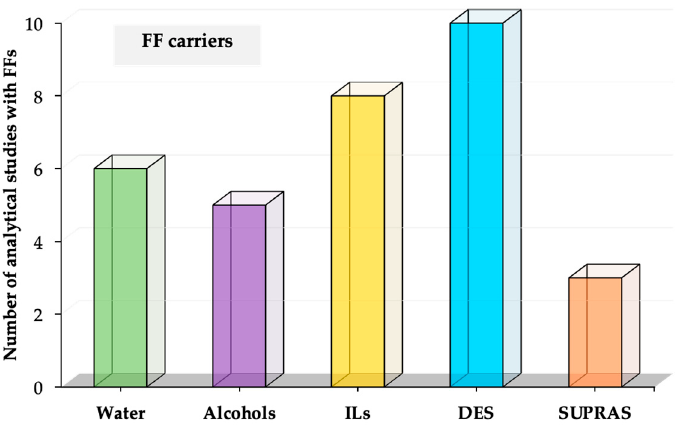
Figure 2. Number of analytical applications using FFs, with the type of FF classified as a function of the different carriers used for their formation.